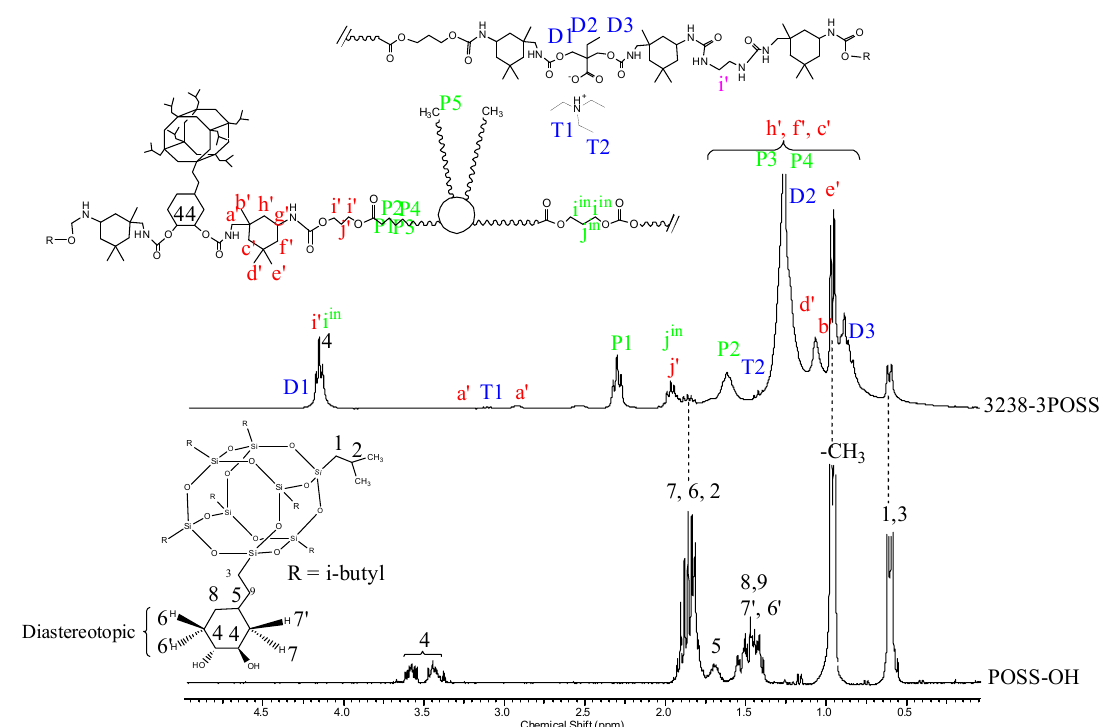
Figure 7. 1 H NMR of experiment 3238-3PDO and starting polyol Priplast 3238 with peak assignments.